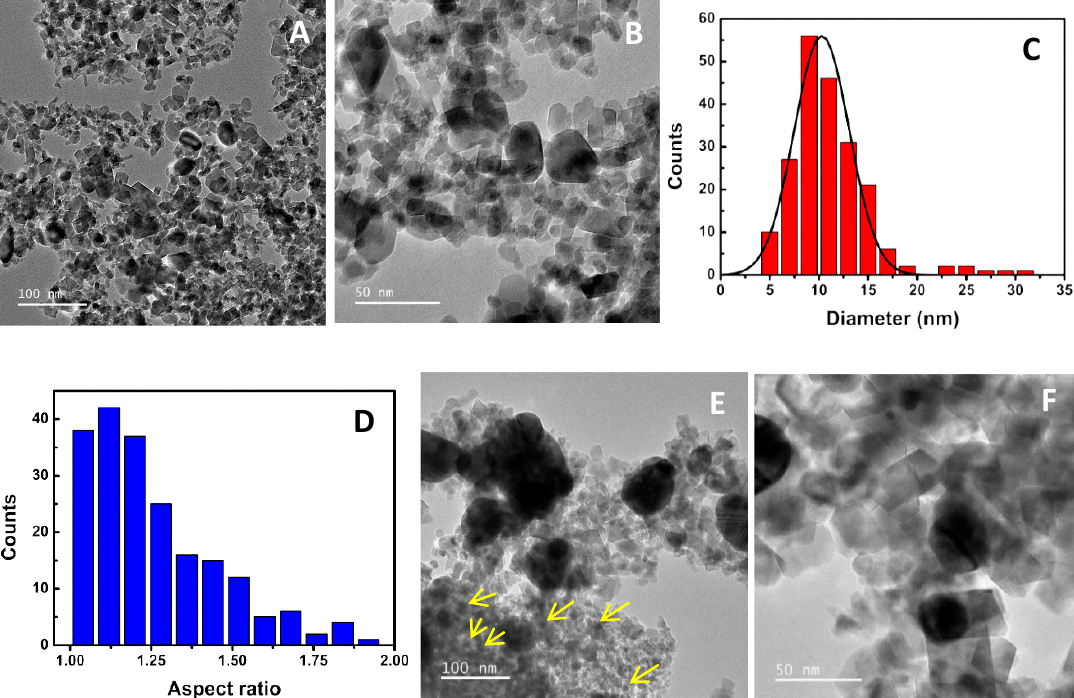
Figure 3. TEM images of the synthesized nanoparticles. ( A , B ): Zinc / calcium ferrite nanoparticles; ( C ): Particle size histogram of image ( B ) and fitting to a Gaussian distribution; ( D ): Aspect ratio histogram of particles in image ( B ); ( E , F ): Zinc / calcium ferrite nanoparticles containing